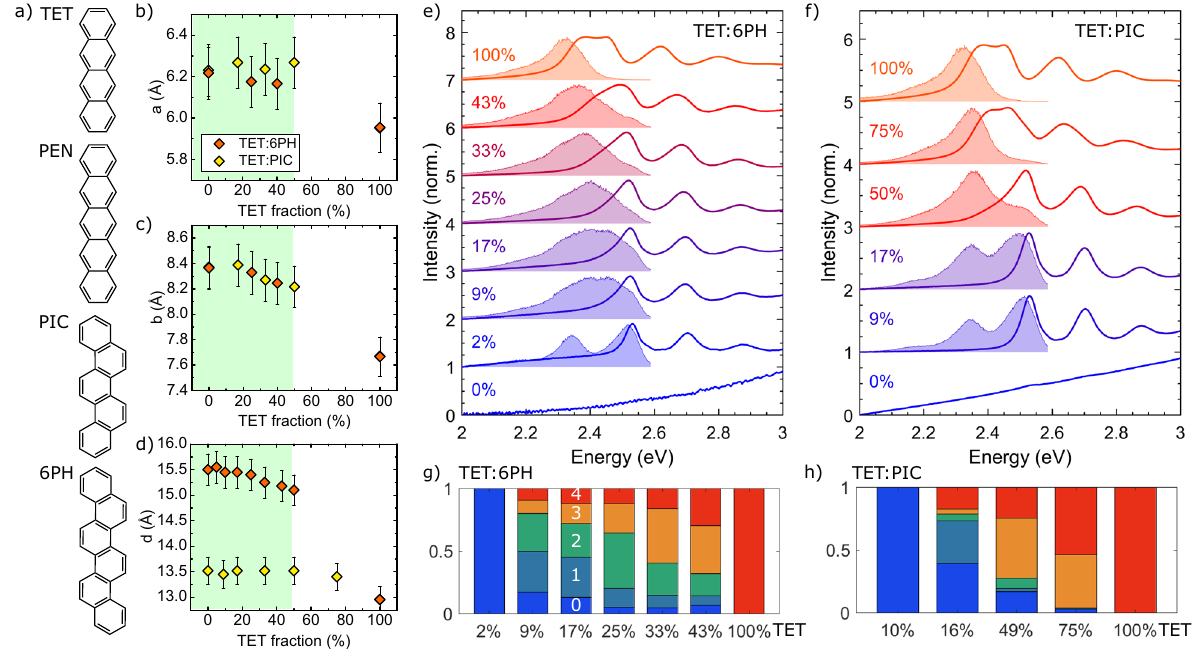
Fig. 1 Structural and optical properties of TET blends. a Chemical structures of TET, PEN, PIC and 6PH. b – d In-plane unit cell parameters a and b and out- of-plane lattice spacing d for TET blends with varying concentrations of spacer molecules. The areas shaded in light green denote the range of TET fractions relevant for this study. The legend in b applies to b – d . The error bars have been determined as 2% of the experimental value. e , f Absorption spectra (solid lines) and photoluminescence (PL) spectra (shaded areas), offset for clarity, for e TET:6PH blends and f TET:PIC blends. g , h Decomposition of the PL spectra with differing TET fractions into fi ve contributions, depending on the number of TET neighbours for a given TET molecule (numbers given in the bars; see also Figs. S6-S8). The monomer contribution corresponds to 0 TET neighbours while the bulk contribution corresponds to 4 TET neighbours. For details, see